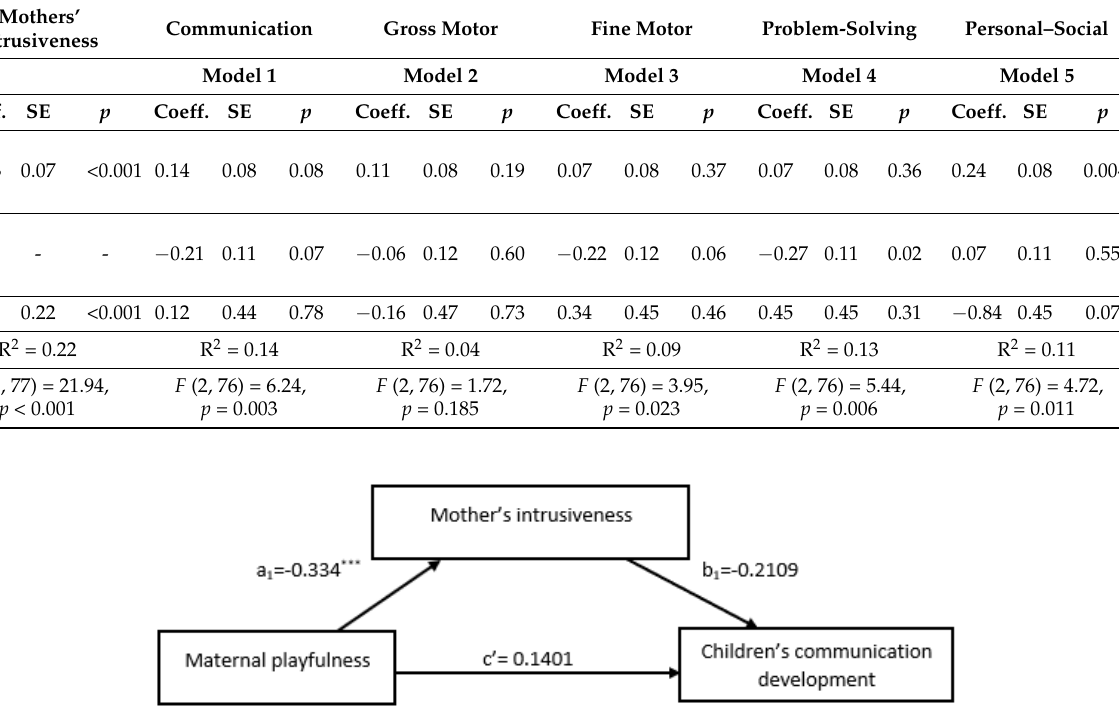
Table 3. Model coefficient effect of maternal playfulness on each ASQ-3 area of children’s development.